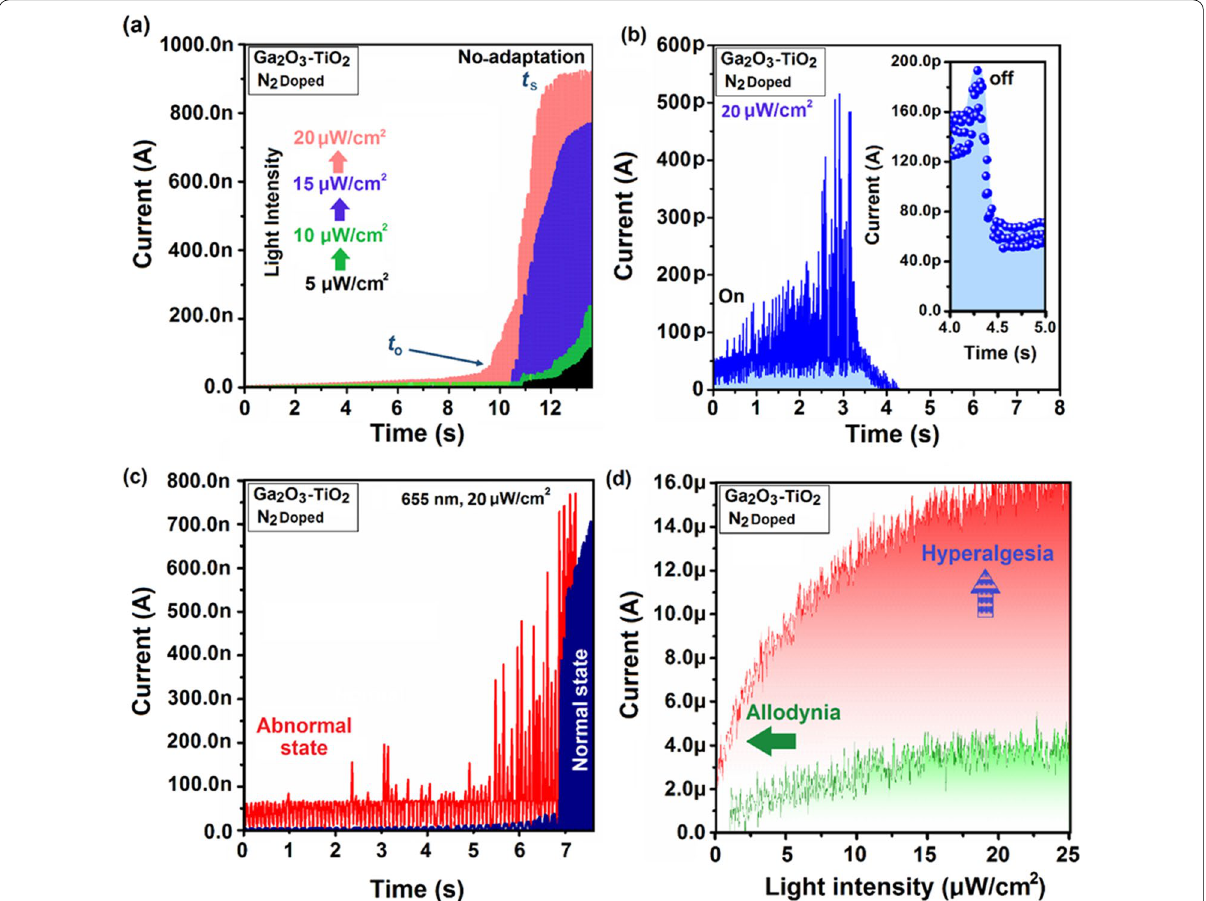
Fig. 21 a The photoinduced nociceptive behavior of Ga 2 O 3 (N 2 )/TiO 2 -based heterostructured devices. The effect of light intensity ( λ threshold time ( t 0 ) and saturation time ( t s ) of Ga 2 O 3 (N 2 )/TiO 2 nociceptor. The light frequency was 20 Hz. b The relaxation characteristics of Au- Ga 2 O 3 (N 2 )/TiO 2 -ITO nociceptor. The light frequency was 20 Hz. c The distinction of photoresponse behavior of Au-Ga 2 O 3 (N 2 )/TiO 2 -ITO nociceptor in normal and abnormal state. The light frequency was 20 Hz. d The allodynia and hyperalgesia behavior of Au-Ga 2 O 3 (N 2 )/TiO 2 -ITO opto-nociceptor. Reprinted with permission from